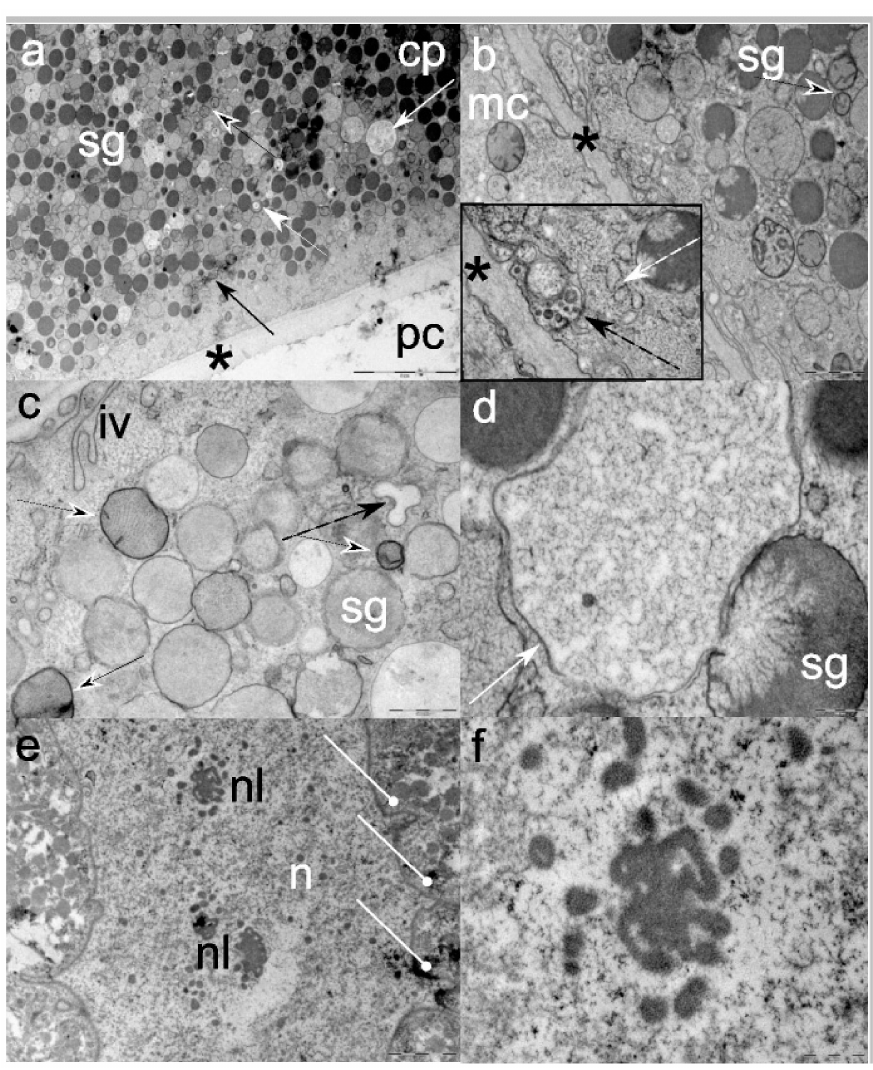
Figure 2. Representative electron micrographs of third-stage Anisakis pegre ffi i excretory cells: ( a ) Electron-dense serous- and electron-lucent mucin-like secretory granules (sg) in the cell cytoplasm (cp) lined by a proteinaceous layer (*) in contact with the pseudocoelom (pc). Note small Golgi apparatus (black arrow), mitochondria (black arrowhead), multivesicular body (white arrowhead), and vacuole likely filled with accumulated, misfolded products; ( b ) a cell filled with secretory granules (sg) is in close contact with a somatic muscular cell (mc) through the proteinaceous layer (*). Note small and spherical mitochondria (black arrowhead). Insert: Multiple invaginations of the plasmalemma show endocytosis and formation of endosomes with multiple vesicles (dashed black arrow). Note ribosomes on the rough endoplasmic reticulum (dashed white arrow); ( c ) plasmalemma invaginations (iv) in the cytoplasm rich with electron-lucent mucin-like secretory granules (sg), spherical mitochondria with lamellar appearance of matrix and few short cristae (black arrowhead) and empty endosomes (dashed black arrow); ( d ) electron-dense serous-like secretory granule (sg) expelling its product in a large vesicle of irregular shape (white arrow); ( e ) nucleus (n) and two nucleoli (nl). Note extravagination of nucleolar karyotheca (white round-tip arrows); ( f ) Granular component of the nucleolus. Scale bars: ( a ) 5 µ m; ( b ) 1 µ m (insert 500 nm); ( c ) 500 nm; ( d ) 200 nm; ( e ) 2 µ m; ( f ) 500